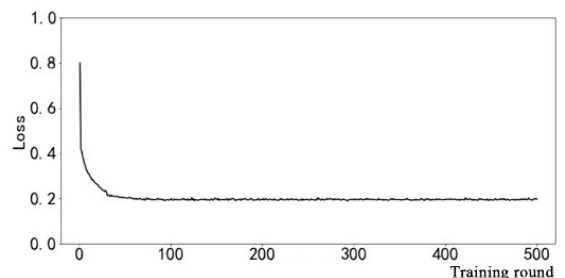
Figure 17. Full expert-driven learning.